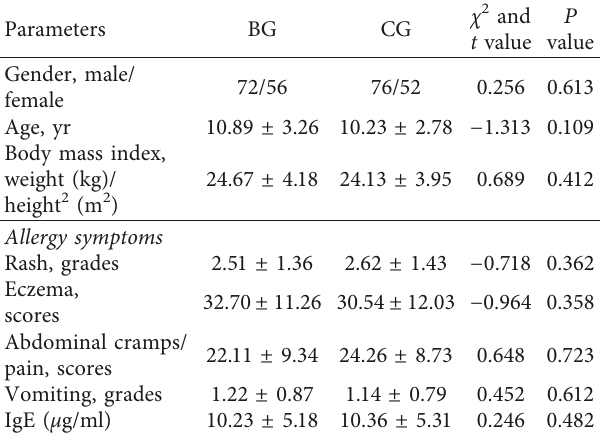
Table 4: Clinical characteristics.